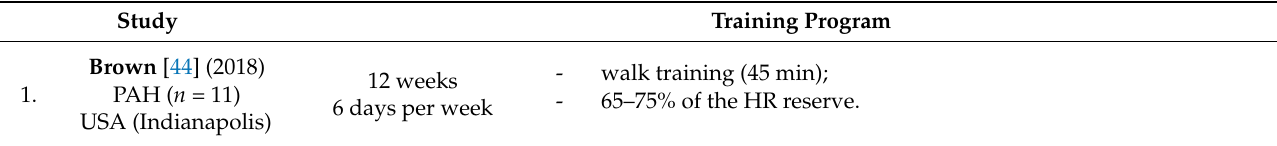
Table 1. The summary of home-based physical training program